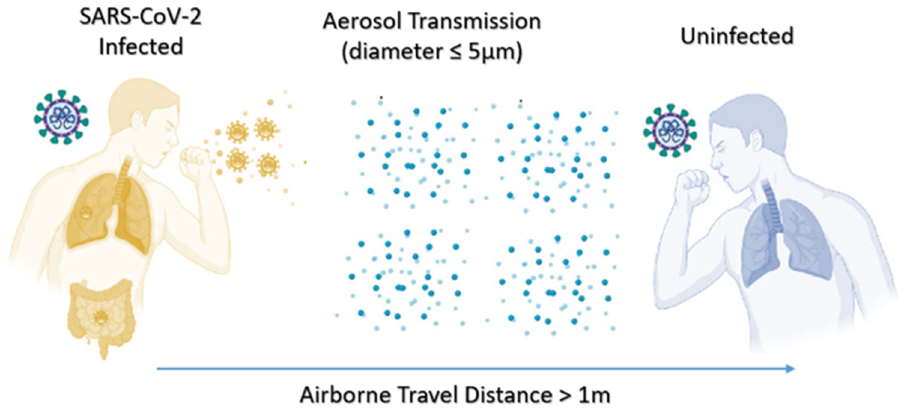
Figure 9. Delta variant aerosol